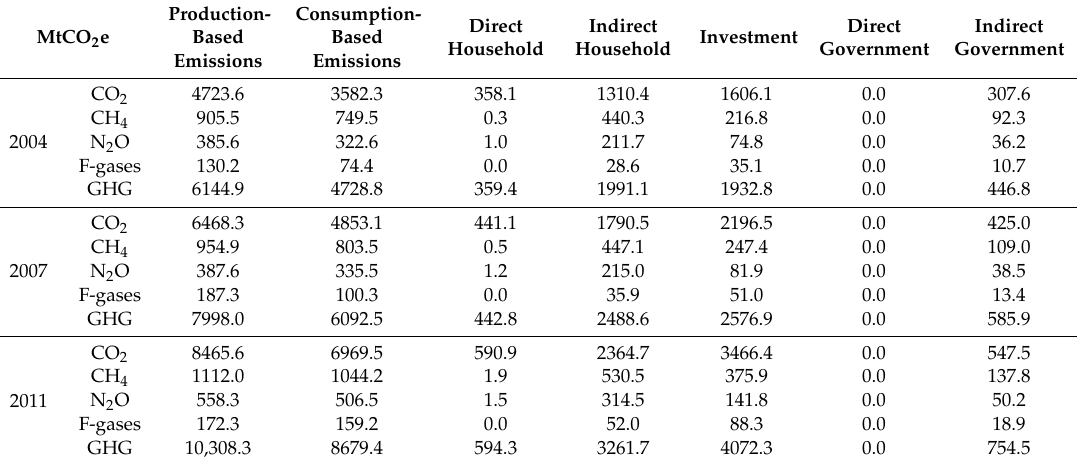
Table 1. China’s GHG emissions in 2004, 2007 and